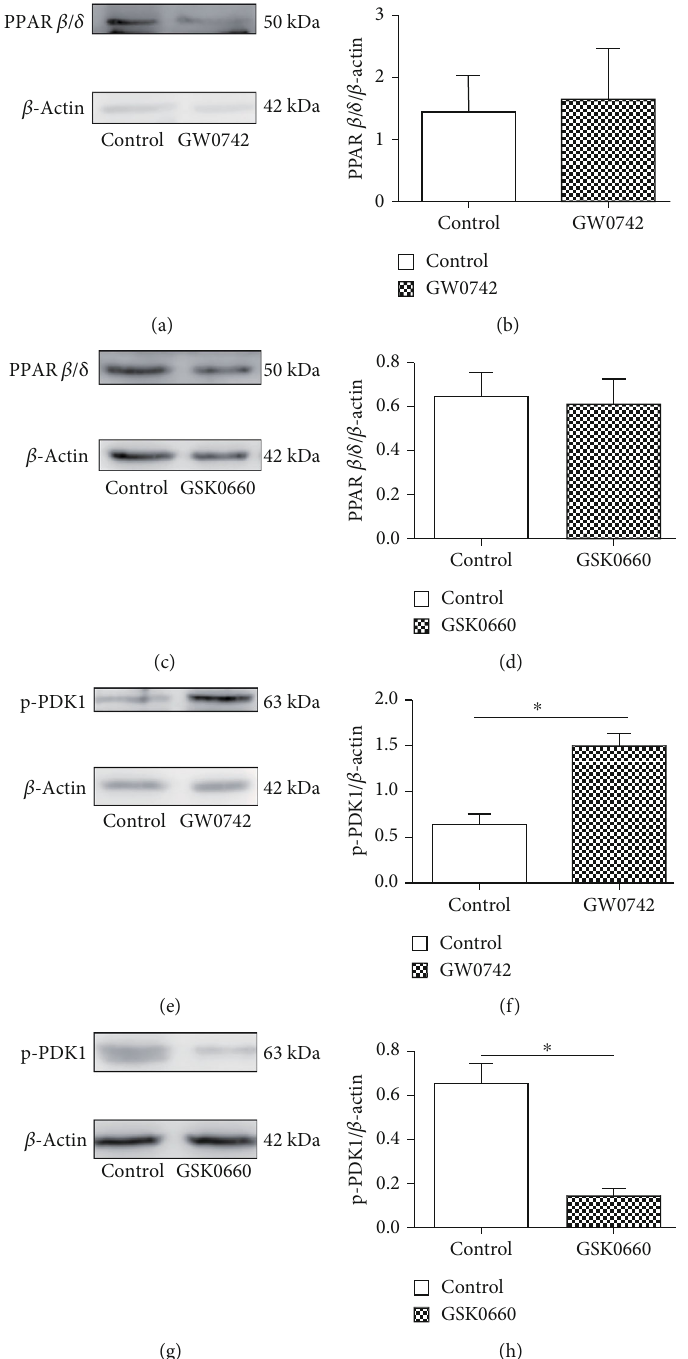
Figure 3: Expression of PPAR β / δ and ligand activation of target gene (PDK1) in cholesteatoma keratinocytes. (a, c) Expression of PPAR β / δ was quanti fi ed by immunoblot after treating with 100 nM GW0742 (a) or 5 μ M GSK0660 (c) for 24h. (e, g) The e ff ect of PPAR β / δ agonist (e) or antagonist (g) on expression of the PPAR β / δ -dependent target gene PDK1 was determined by immunoblot following ligand activation of PPAR β / δ with 100 nM GW0742 or 5 μ M GSK0660 for 24h. (b, d, f, and h) Data are expressed as the mean ± SD of the mean for experiments run in triplicate. ∗ p < 0 : 05 (vs. control